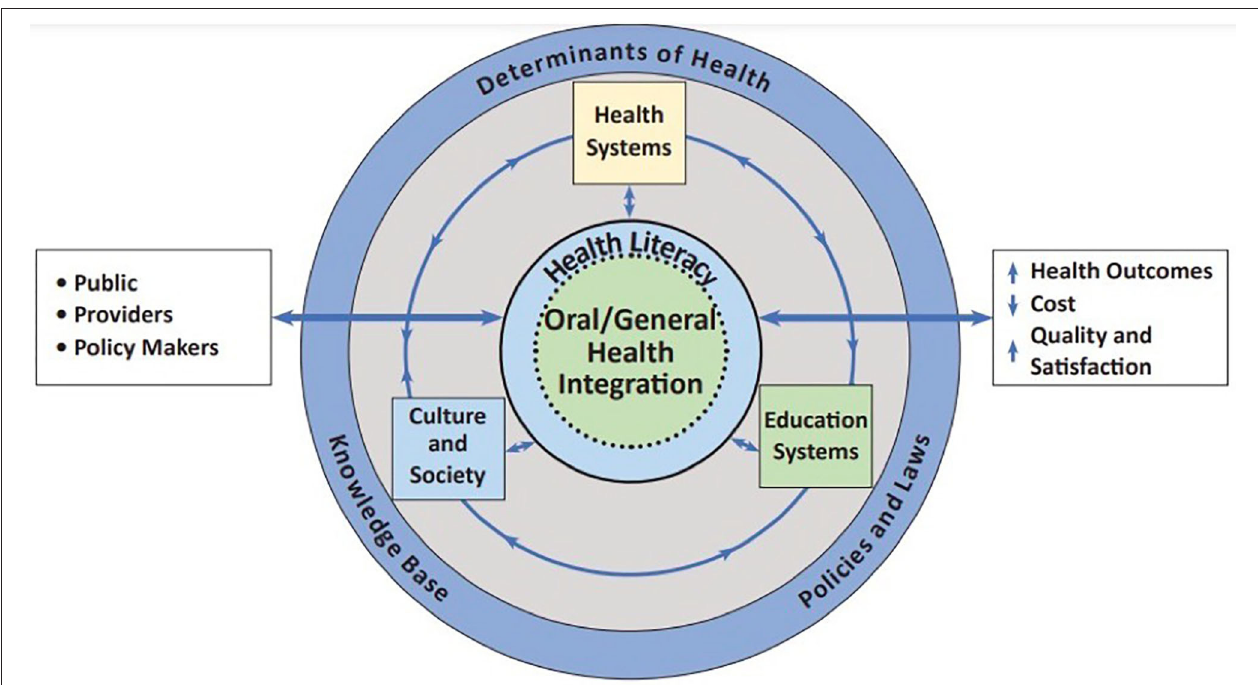
FIGURE 1 | Oral health literacy and health integration framework. Adapted and reproduced with permission from the National Academy of Sciences, Courtesy of the National Academies Press, Washington, DC ( 24).